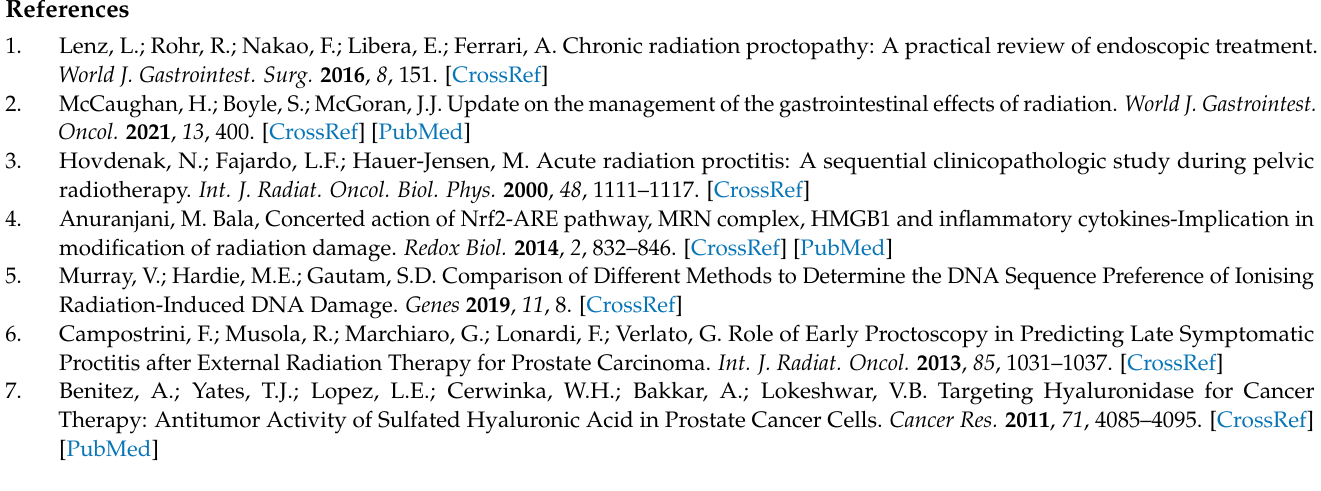
Sacrifice Histological Scoring, Table S1: Differentially Expressed Genes, Table S2: Canonical Pathways, Table S3: Upstream Regulators, Table S4: Gene Ontology